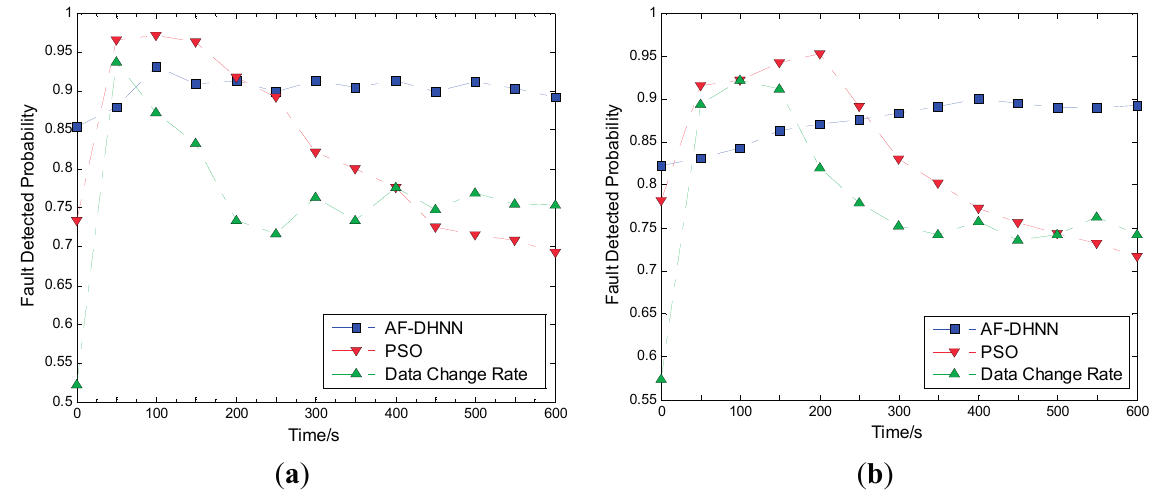
Figure 18. Performances of diagnosis methods compared in fire. ( a ) flue gas dimming extent change; ( b ) ambient temperature